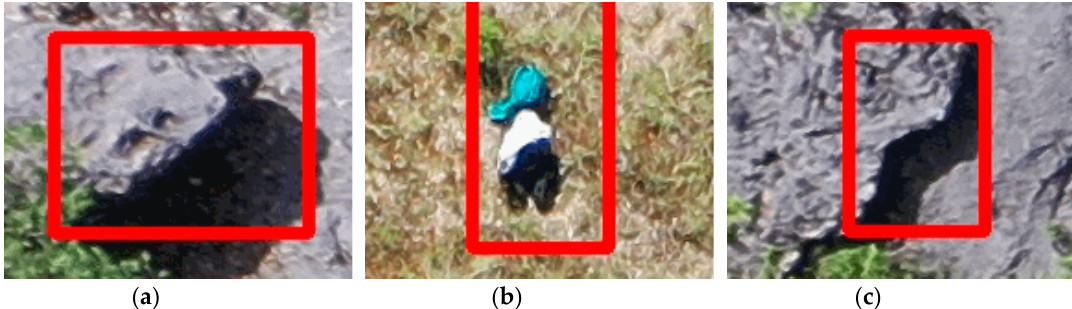
Figure 11. False negative examples for the ScoreMap to ROI algorithm: ( a ) The person is in occlusion, ( b ) The person is dressed in grey clothes and black pants and it is very difficult to distinguish him or her from the environment, ( c ) The person is in occlusion, and only parts of his clothing and arms are clearly visible.